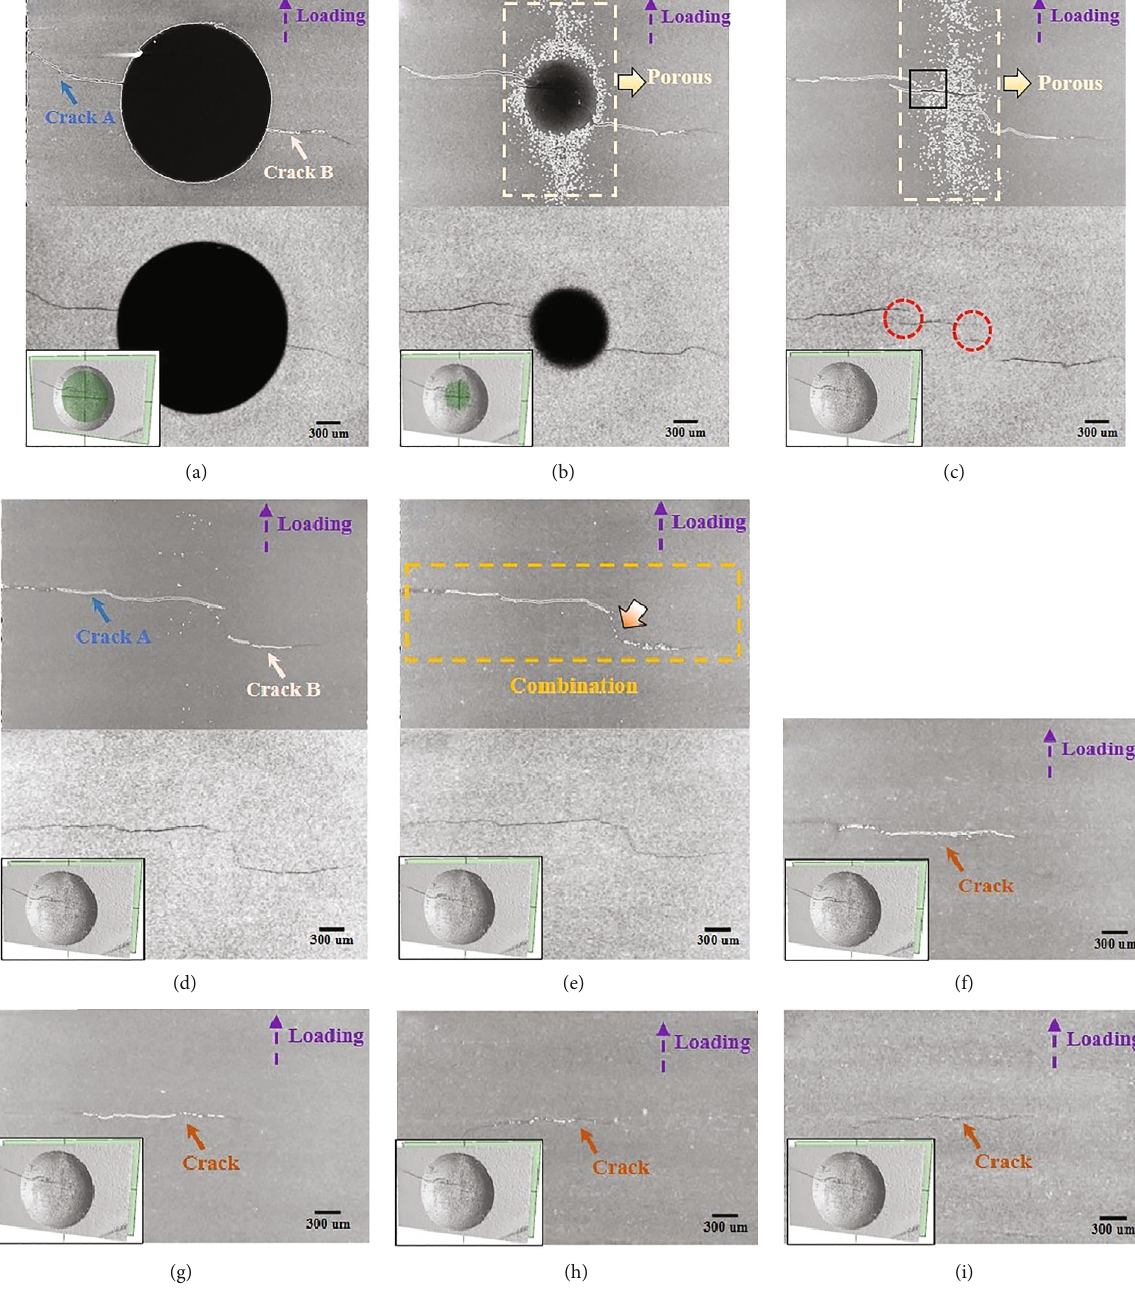
Figure 9: Front views in various scanning planes along the normal